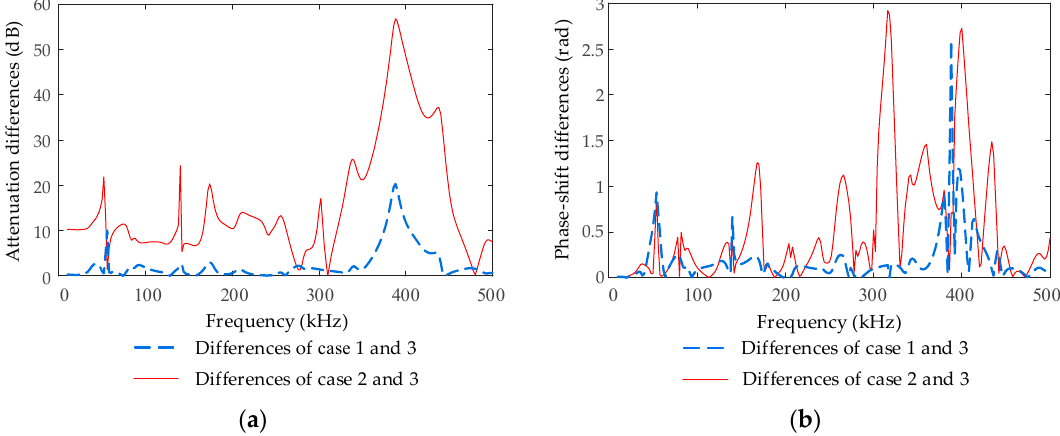
Figure 11. Differences of frequency response characteristics under different grounding impedances. ( a ) The absolute values of differences of amplitude-frequency characteristics; ( b ) The absolute values of differences of phase-frequency characteristics. Case 1: The grounding resistances were 2 Ω and grounding inductances were zero. Case 2: The grounding resistances were 2 Ω and the grounding inductances were 5 μ H. Case 3: The grounding impedances were zero.